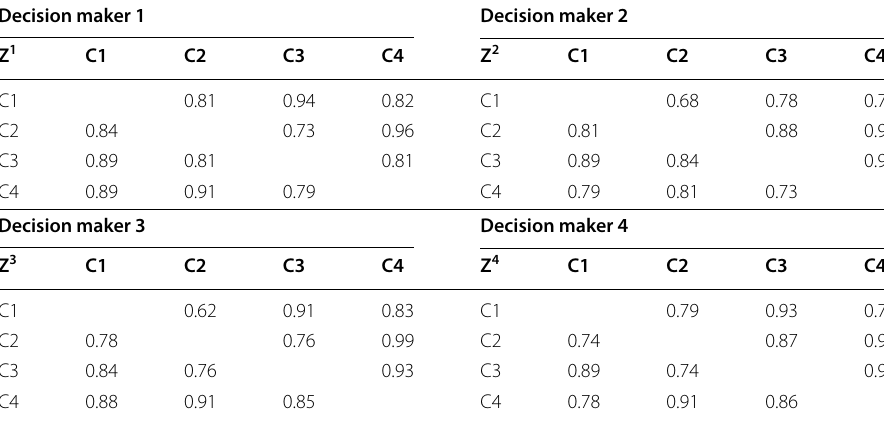
Table 10 Consensual fuzzy preference degrees for revenue sharing model Decision maker 1